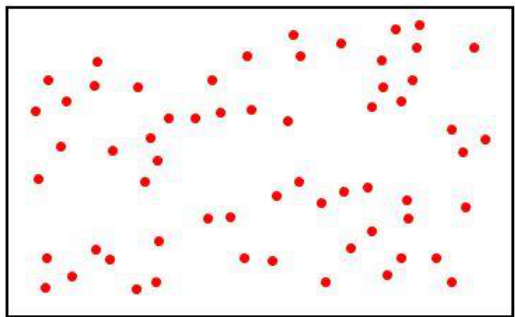
Figure 3 Pattern of points before clustering